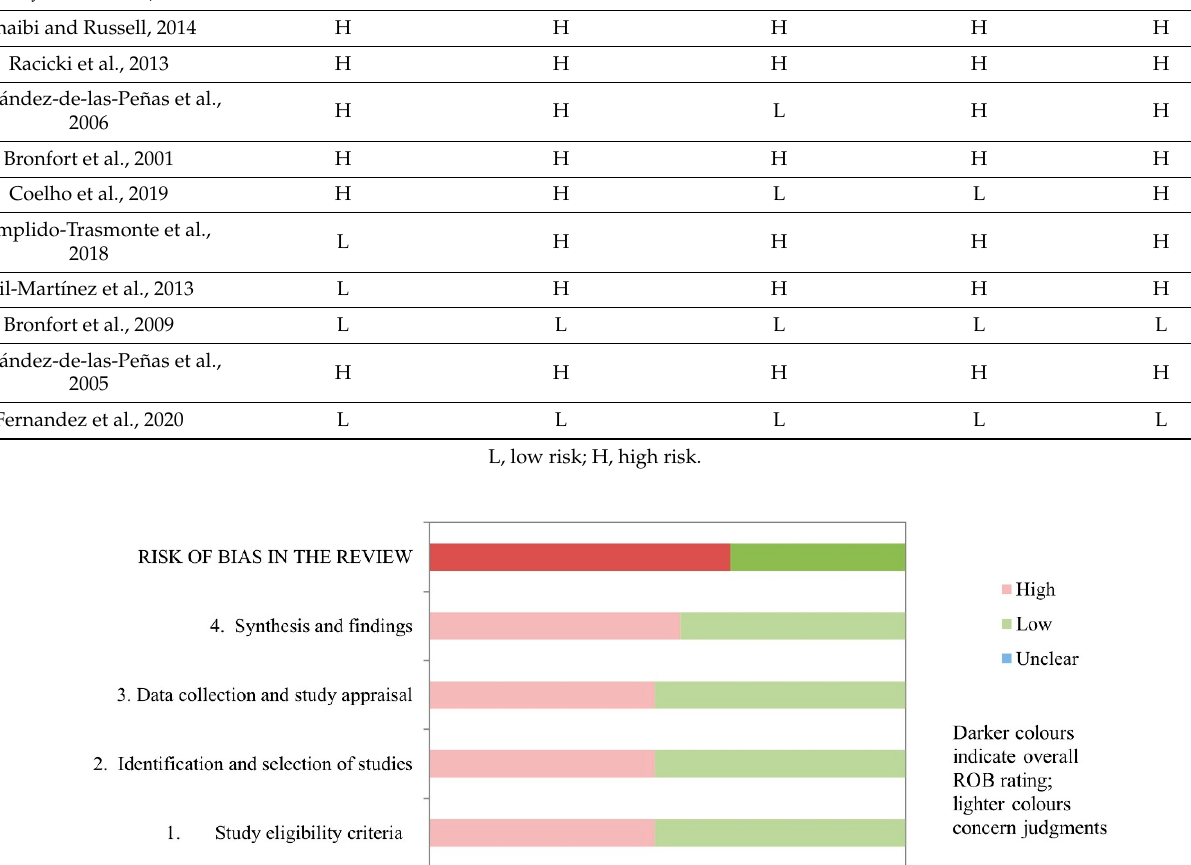
Table 4. Risk of bias assessment in systematic reviews through the ROBIS scale.